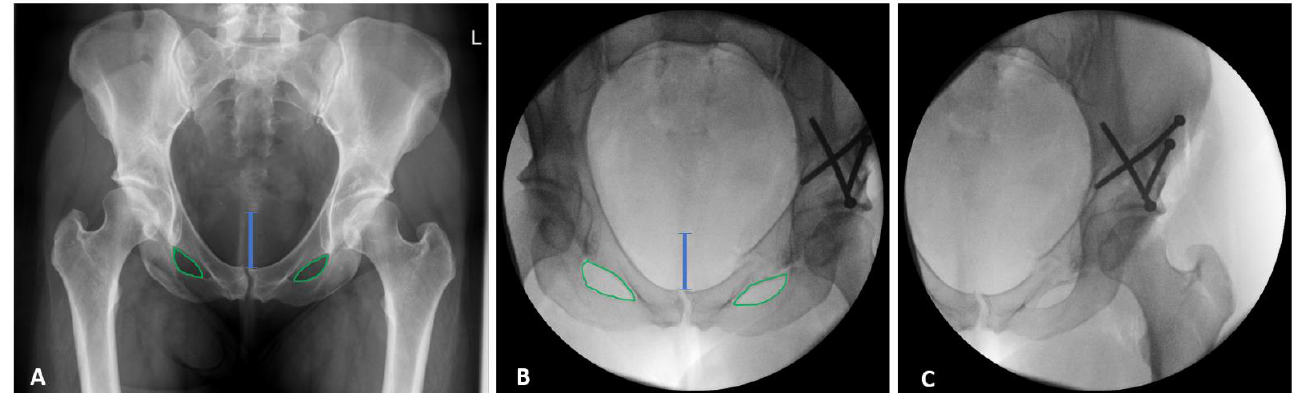
Figure 1. Preoperative radiograph ( A ) and intraoperative fluoroscopy ( B ) of the pelvic ring and the obturator foramen (green line) with adjusted tilt, rotation, and coccyx alignment, and with the distance (blue line) from the symphysis to match the preoperative radiograph. Visualized operated hip after lateralization of the C-arm for image acquisition ( C ).